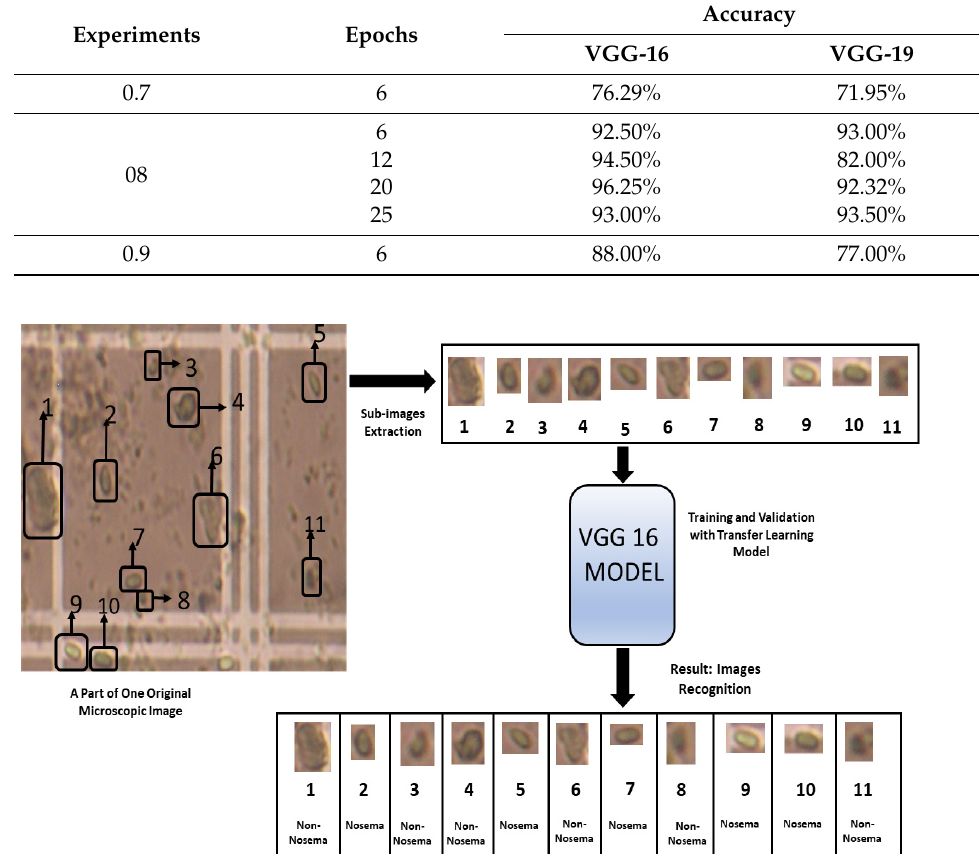
Figure 7. The steps followed for the recognition of Nosema cells using VGG 16 Model.